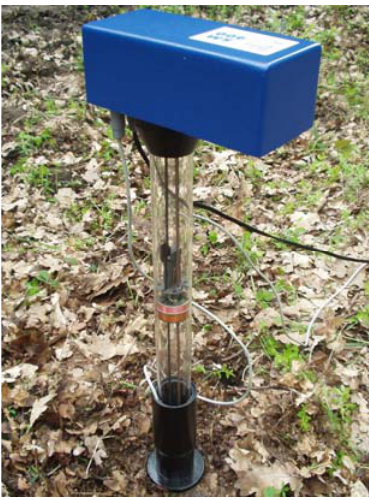
Fig 2. Surface magnetic workability measuring